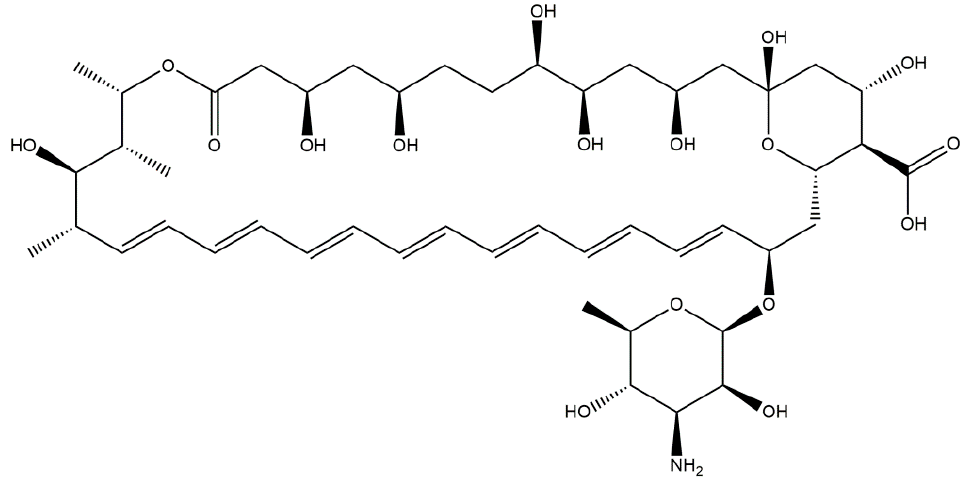
Figure 4. Chemical structure of Amphotericin B.